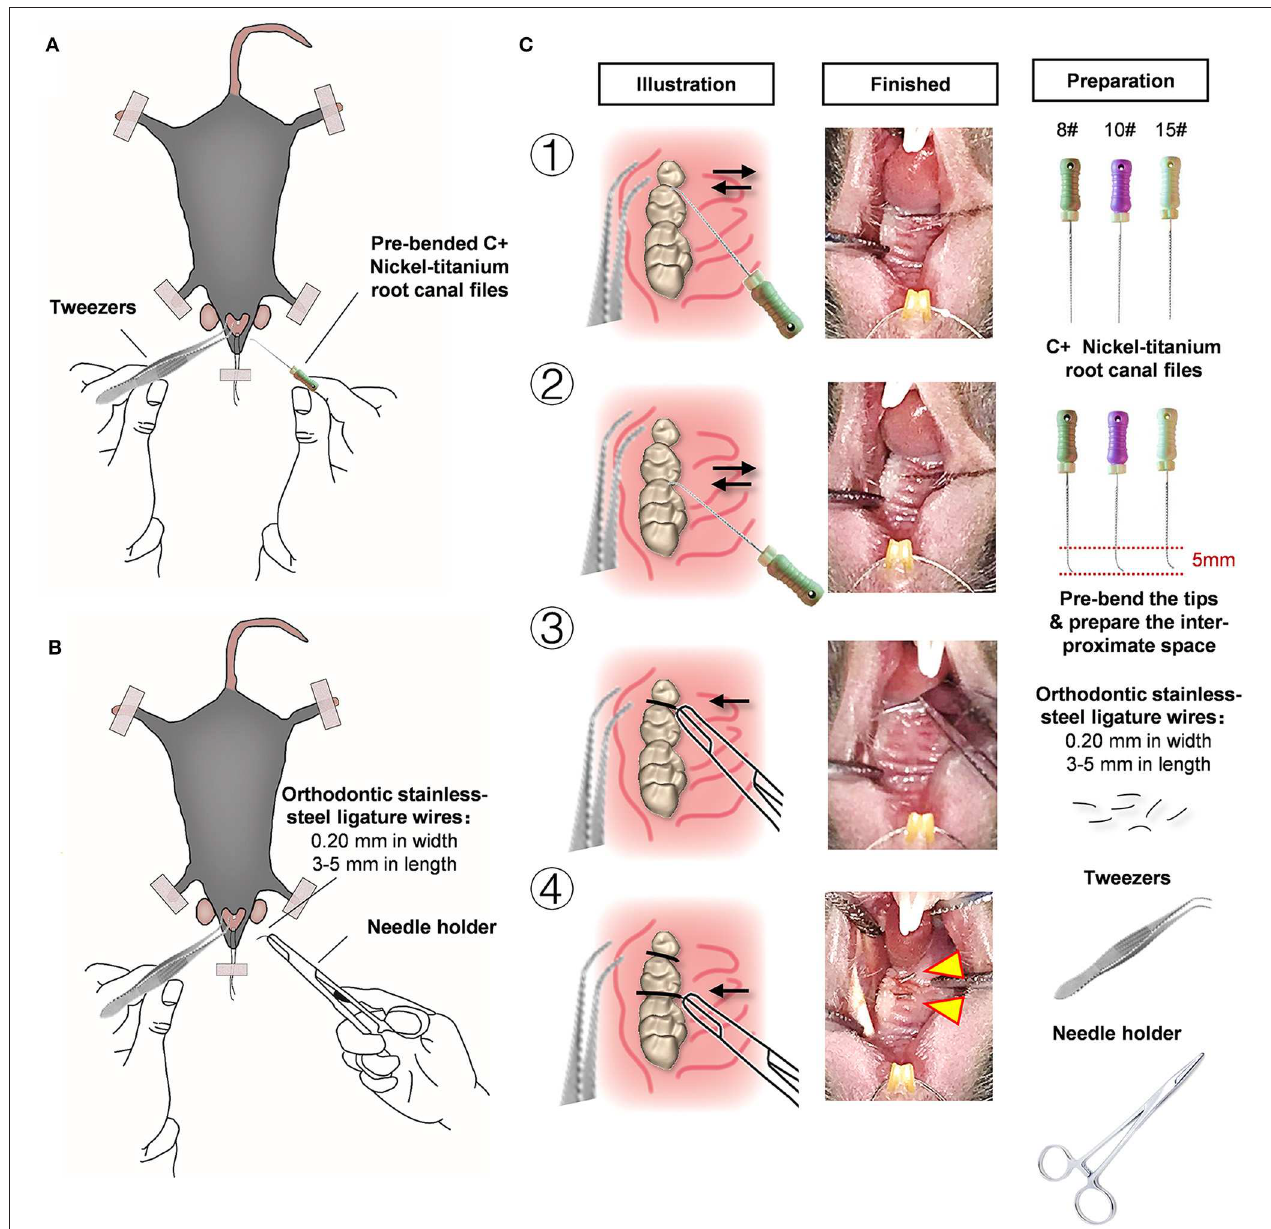
FIGURE 1 | An effective and simple experimental mice model for periodontitis research. (A) Pre-bend the 5mm tip area of the C + nickel-titanium root canal file, then slowly file into the adjacent space. (B) Orthodontic ligature wires (cut by 0.2mm in width, 3–5mm in length) were inserted through interdentium between the first molar and second molar, and the second molar and third molar using a needle holder. (C) Detailed procedures and preparation of the modified wire-placement